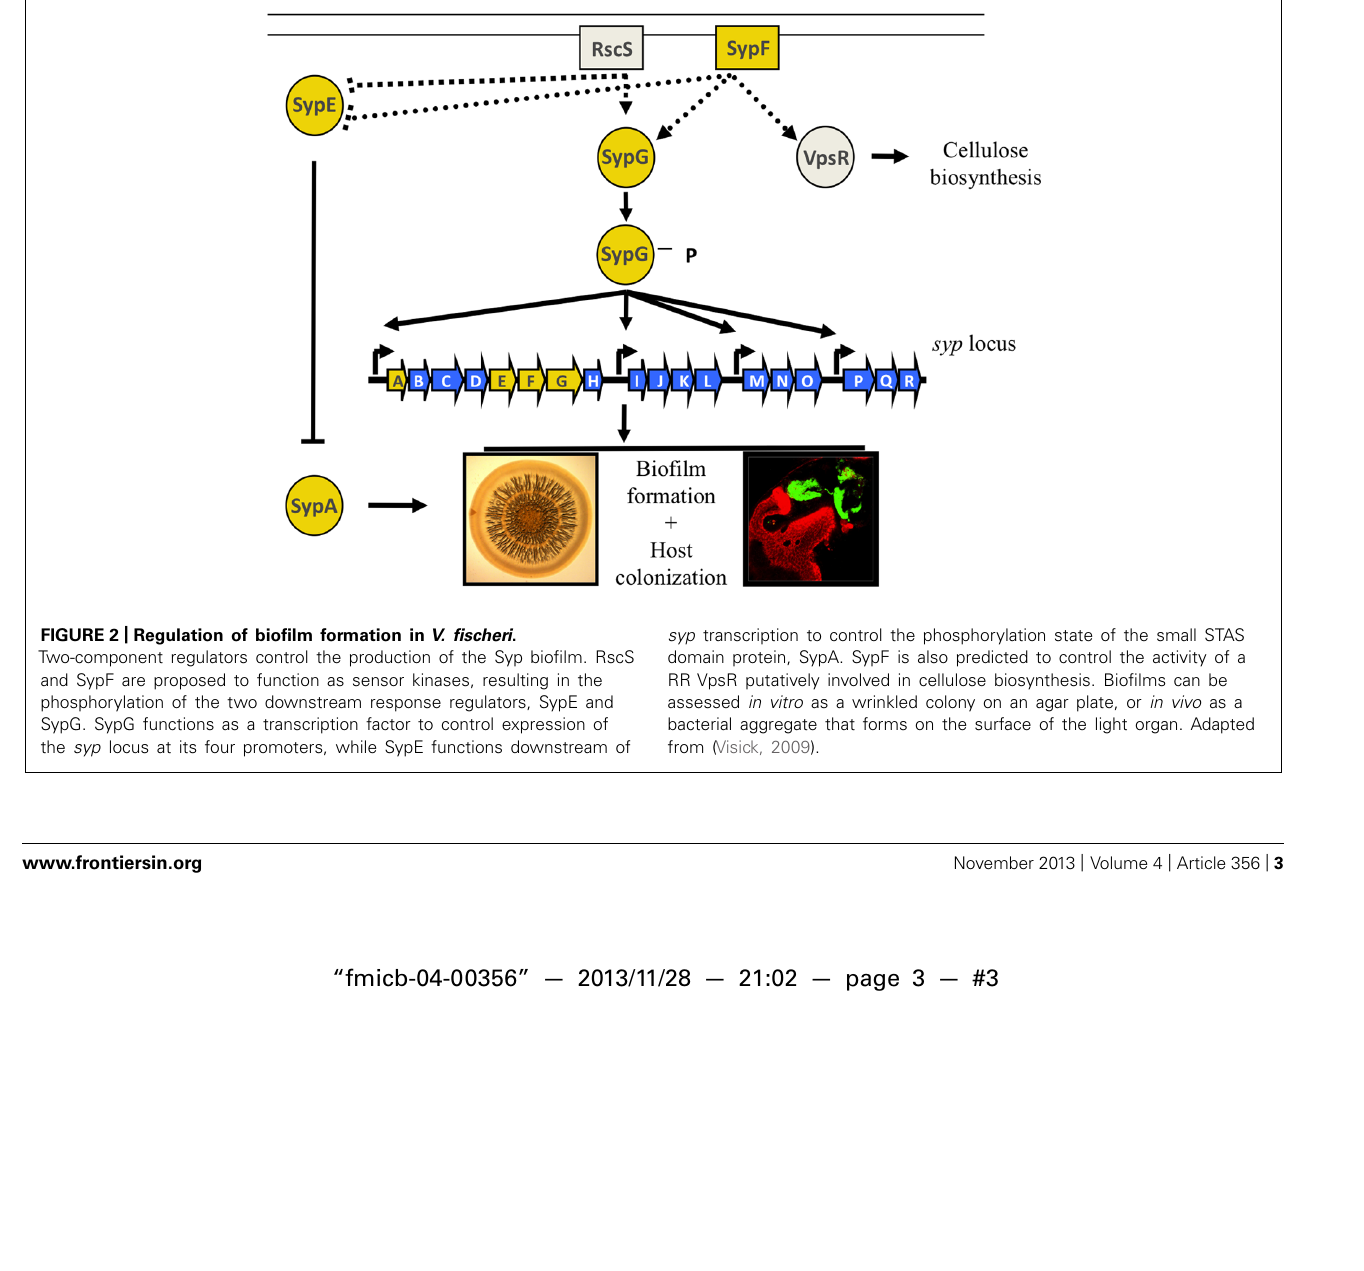
FIGURE 2 | Regulation of biofilm formation in V. fischeri . Two-component regulators control the production of the Syp biofilm. RscS and SypF are proposed to function as sensor kinases, resulting in the phosphorylation of the two downstream response regulators, SypE and SypG. SypG functions as a transcription factor to control expression of the syp locus at its four promoters, while SypE functions downstream of